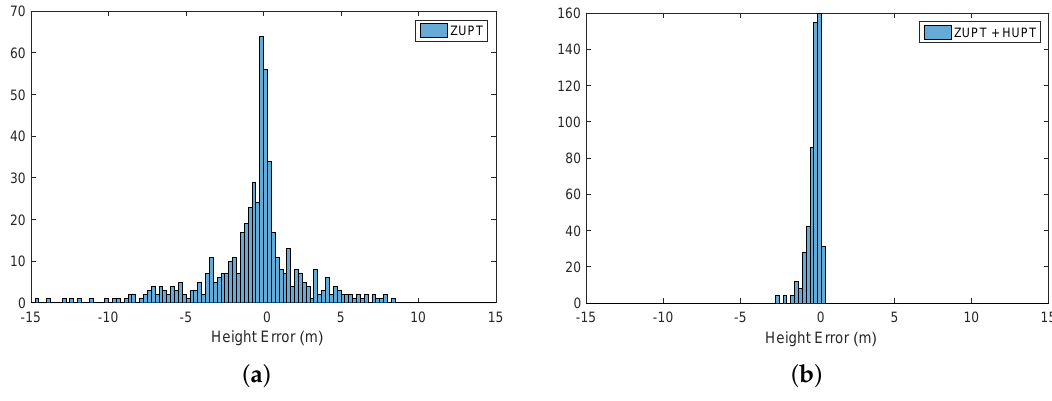
Figure 9. Height error distributions for the evaluated dataset composed of 20 trajectories recorded by 10 volunteers with an overall duration of approximately 5 h. ( a ) shows the result using only ZUPT corrections, and ( b ) shows the result using ZUPT and the proposed HUPT